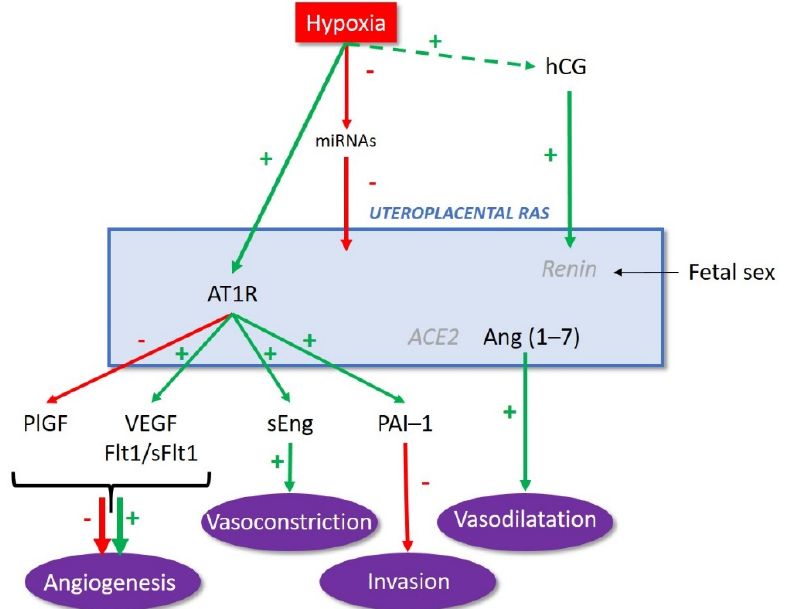
Figure 3. Regulation of the uteroplacental renin–angiotensin system (RAS). hCG: human chorionic gonadotropin; miRNA: microRNA; AT1R: angiotensin II type 1 receptor; ACE2: angiotensin-converting enzyme 2; Ang (1–7): angiotensin (1–7); PlGF: placental growth factor; VEGF: vascular endothelial growth factor; Flt1: Fms-like tyrosine kinase 1; sFlt1: soluble Fms-like tyrosine kinase 1; sEng: soluble endoglin; PAI-1: plasminogen activator inhibitor